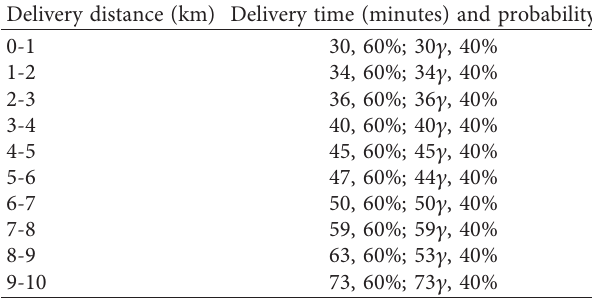
Table 4: Actual delivery time and probability of the rider. Delivery distance (km) Delivery time (minutes) and